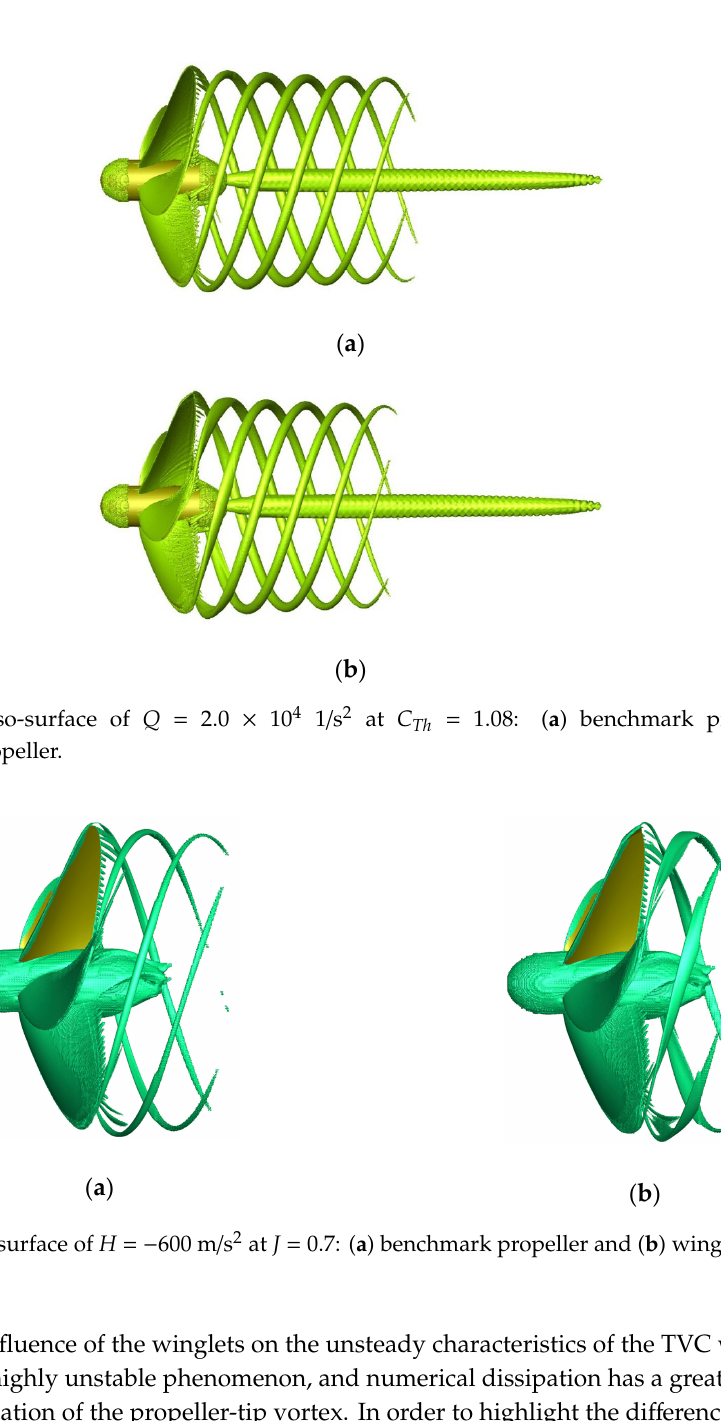
( b ) Figure 22. Iso-surface of 30% vapor volume fraction: ( a ) benchmark propeller and ( b ) winglet- propeller. 4. Conclusions The LES turbulence model was employed to numerically analyze the tip vortex in the wake of marine winglet-propeller. The mesh independence verification and the discretization error estimation were investigated. In addition, the vorticity vector X and the radial velocity fields were studied. The tip vortex structure of the winglet-propeller was shorter than that of the benchmark propeller under the same operating conditions. The existence of winglets reduced the maximum Q - criterion value by approximately 30% at J = 0.7. The cross section of the tip vortex of the benchmark